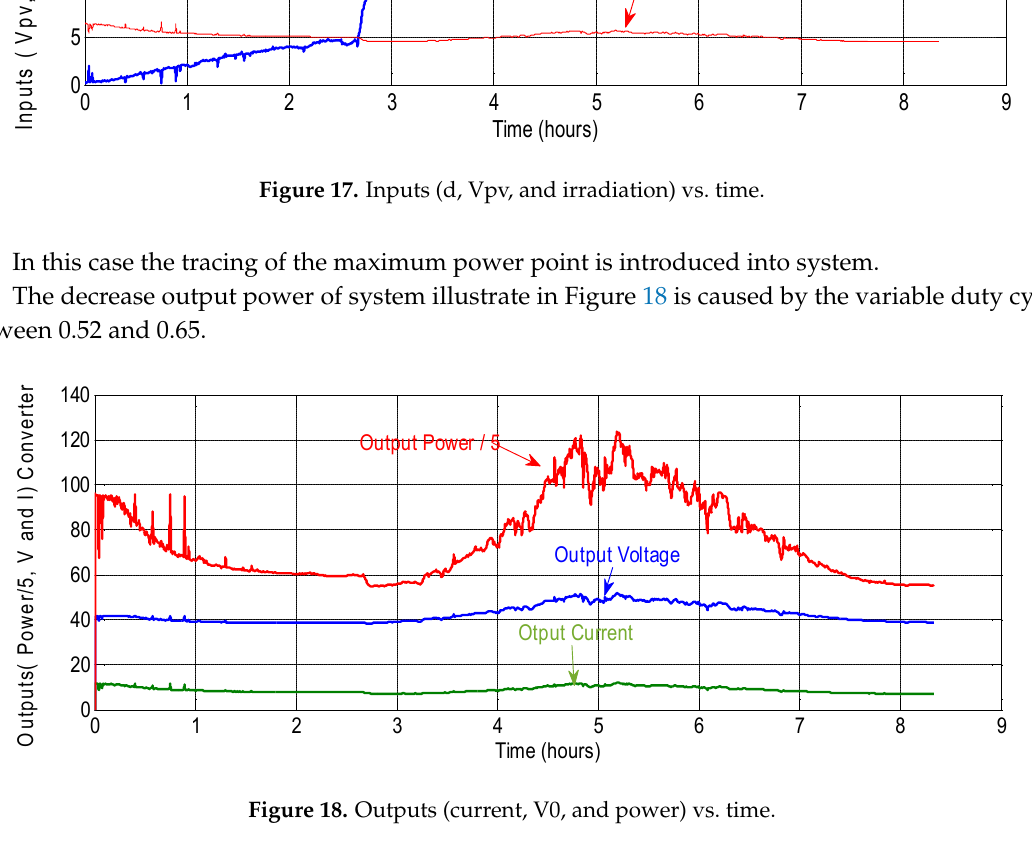
Figure 19. Indicial response of the process.